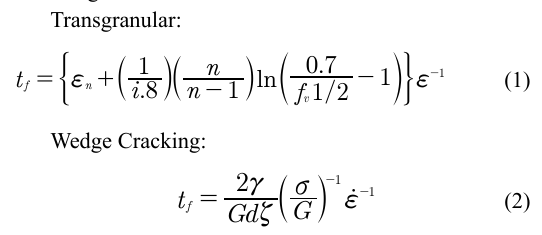
. The values of t f